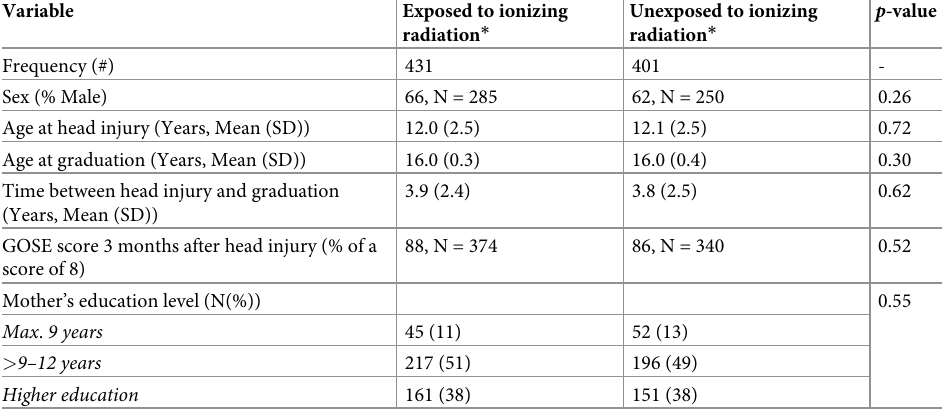
Table 1. Descriptives of participants by exposure of ionizing radiation